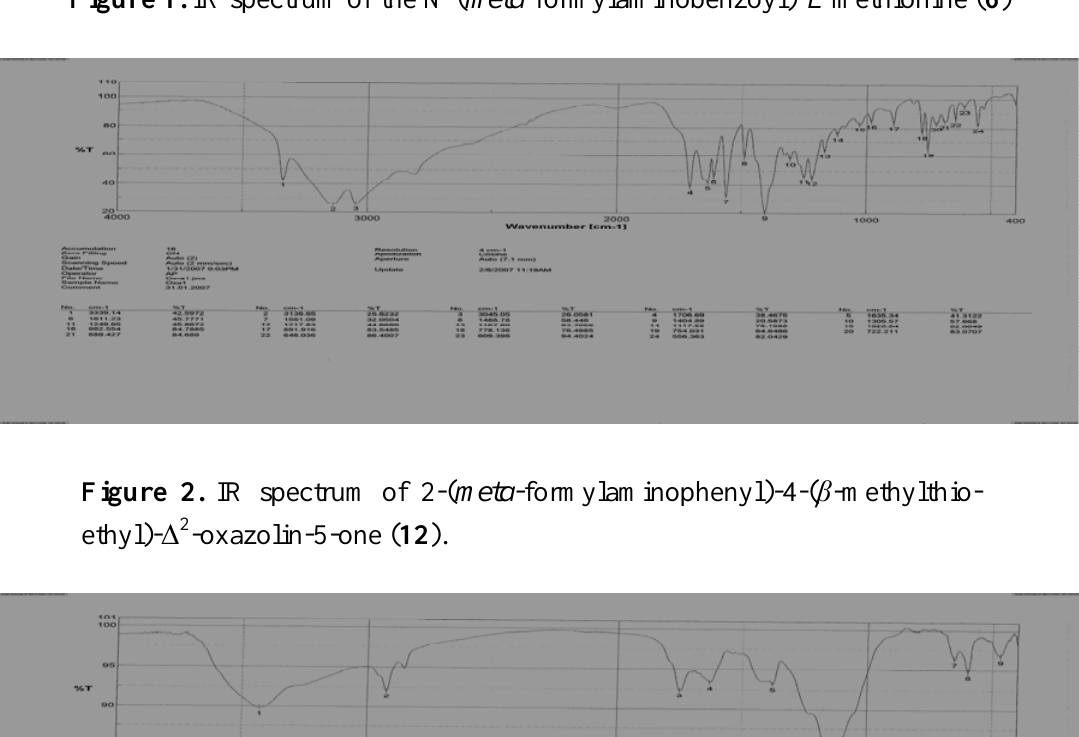
Figure 1. IR spectrum of the N-( meta -formylaminobenzoyl)- L -methionine ( 6 )